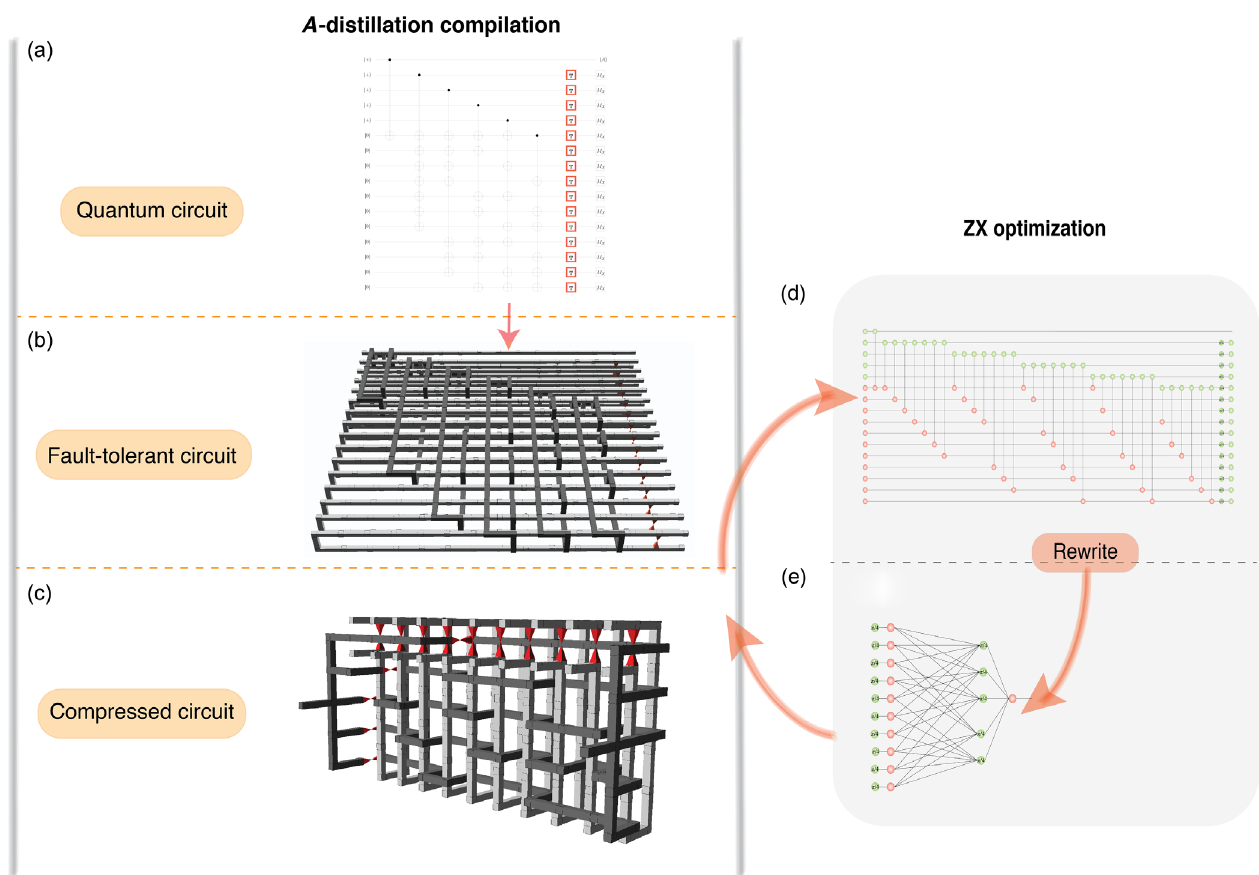
7. Compilation and optimization of the A -distillation circuit. (a) Initial circuit in the diagram form. (b) Initial circuit in the braided representation. (c) Reduced circuit in the braided representation after applying our compression method. (d) Initial circuit in the ZX- calculus representation. (e) Reduced circuit in the ZX-graph representation. Note that the dashed lines indicate periodic